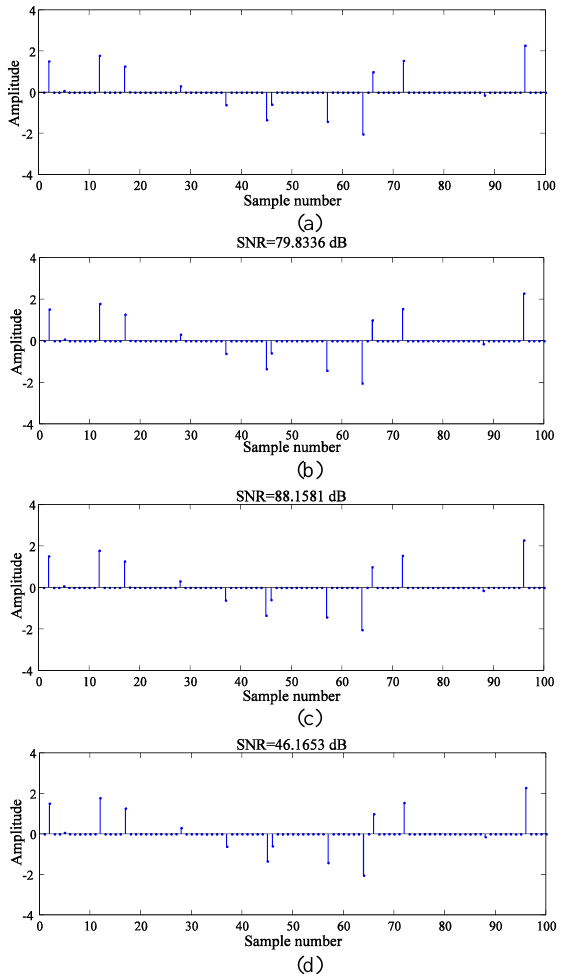
Figure 5. The reconstruction results with corresponding SNRs when the proposed sampling method is used; (a) original signal, and those recovered using (b) BP, (c) OMP, and (d)